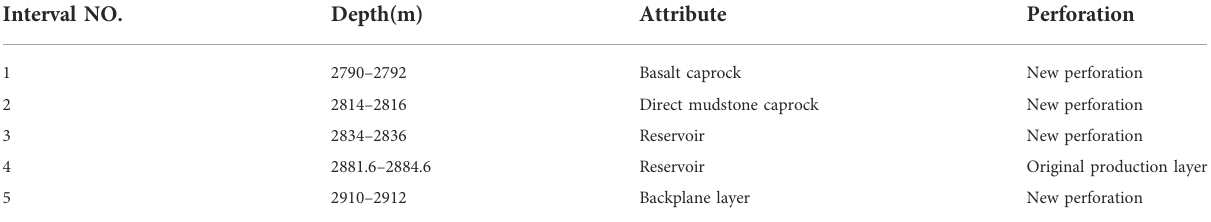
TABLE 1 Test information of the C1 well used for hydraulic fracturing. Interval NO.